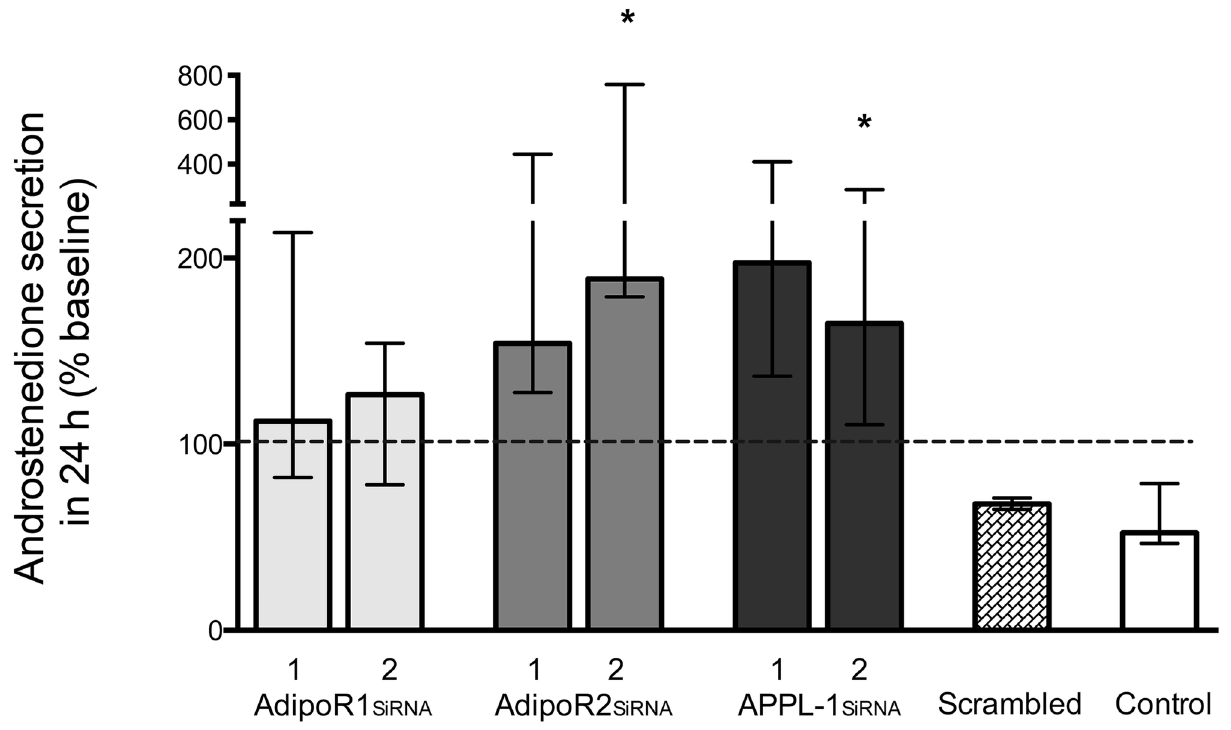
Figure 4. Effect of supression of adiponectin receptor gene expression on androstenedione production by bovine theca cells. Data are expressed as the change (%) from baseline values (0-hr; dotted horizontal line) after 24-h treatment with adiponectin plus LH (10ng/ml). SiRNAs were targeted against 2 separate oligonucleotide sequences (labeled 1 & 2) for each adipokine receptor and their common effector APPL-1 (AdipoR1, AdipoR2, or APPL-1). After 24-h treatment with adiponectin (3 μg/ mL), a relative decrease in androstenedione secretion was observed in the control group (adiponectin alone) and the scrambled RNA group, whereas an increase over 100% (dotted line) was detected in all siRNA groups. Results are shown as medians and interquartile range. Overall changes as a result of siRNA treatments were significant (p=0.04 Kruskal Wallis) with significant changes indicated for knockdown of ADIPOR2 and APPL1 (*p=<0.05, Dunn’s mutiple comparison test vs